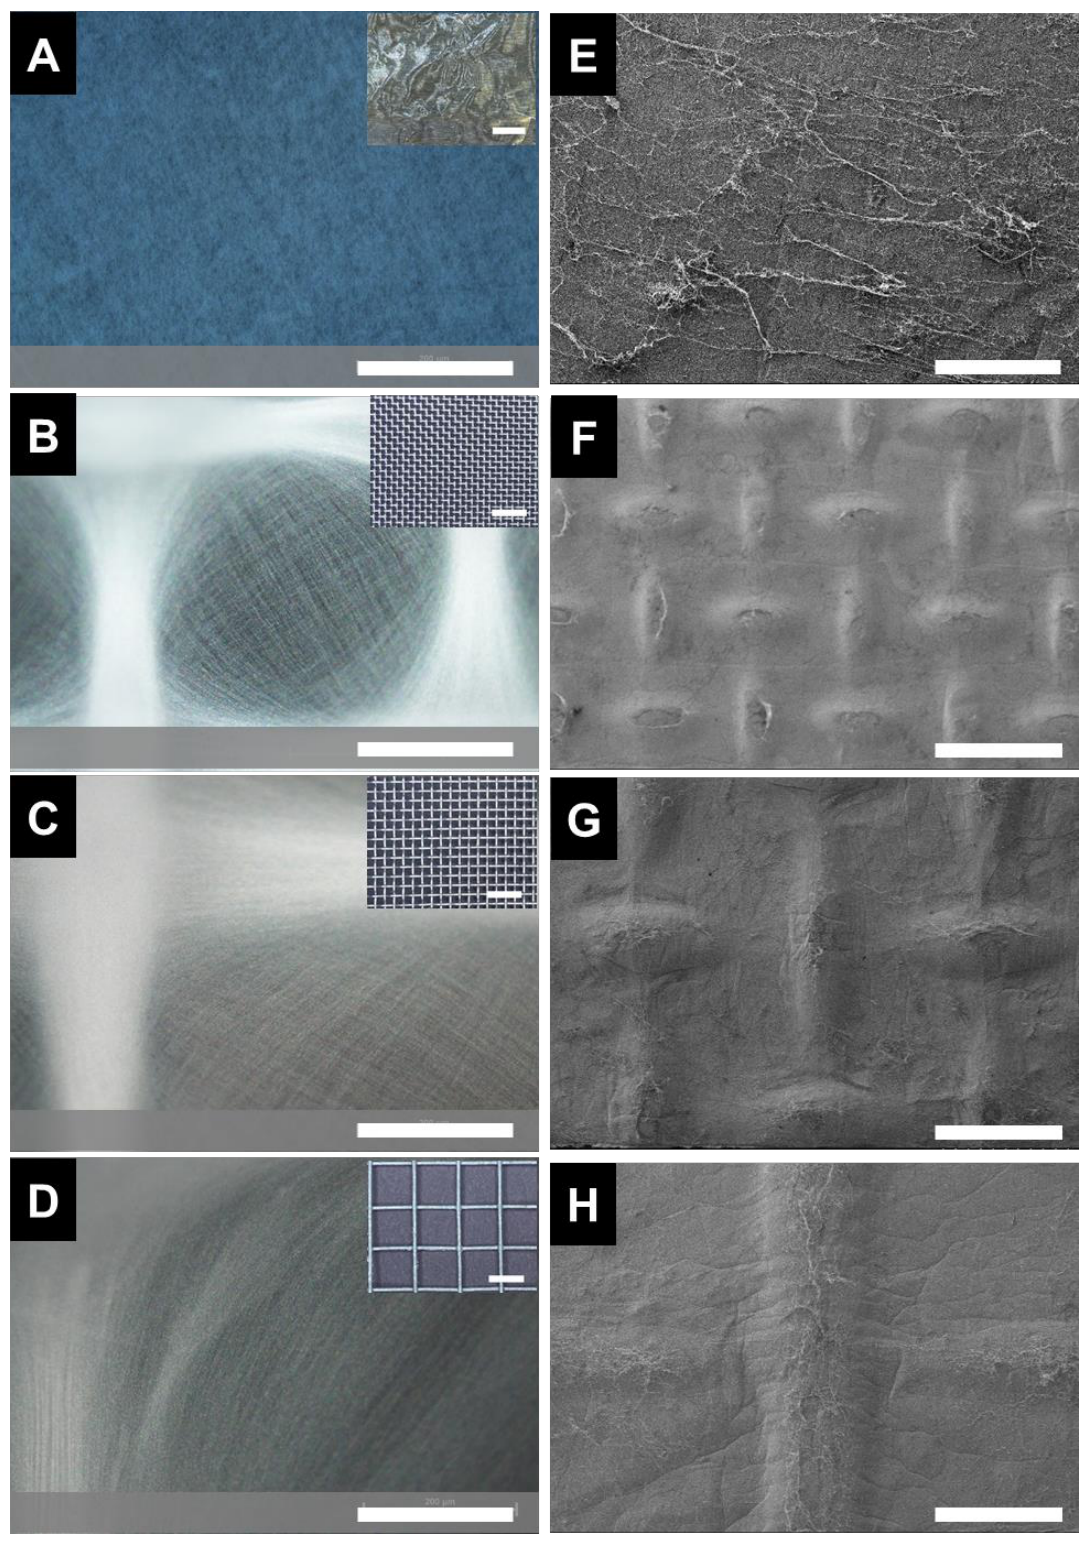
Figure 1. Microscopy of the electrospun samples. Optical micrographs at 10× magnification of samples spun on collected on ( A ) foil, ( B ) 0.6 mesh, ( C ) 0.9 mesh, and ( D ) 6 mm mesh with 200 micron scale bars. The collectors are shown as insets. The scale bars of the insets are 5 mm. SEM micrographs at 30× magnification of samples spun on collected on ( E ) foil, ( F ) 0.6 mesh, ( G ) 0.9 mesh ( H ) 6 mm mesh with 1 mm scale bars.